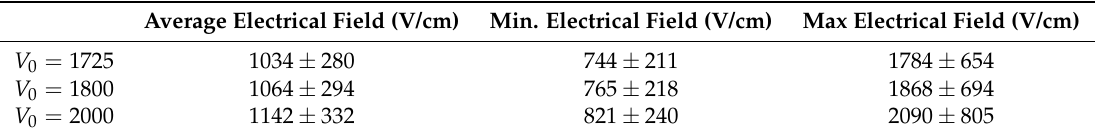
Table 8. Electrical Field Statistics within the Tumor. Varying σ 0 for both liver tissue and the tumor.